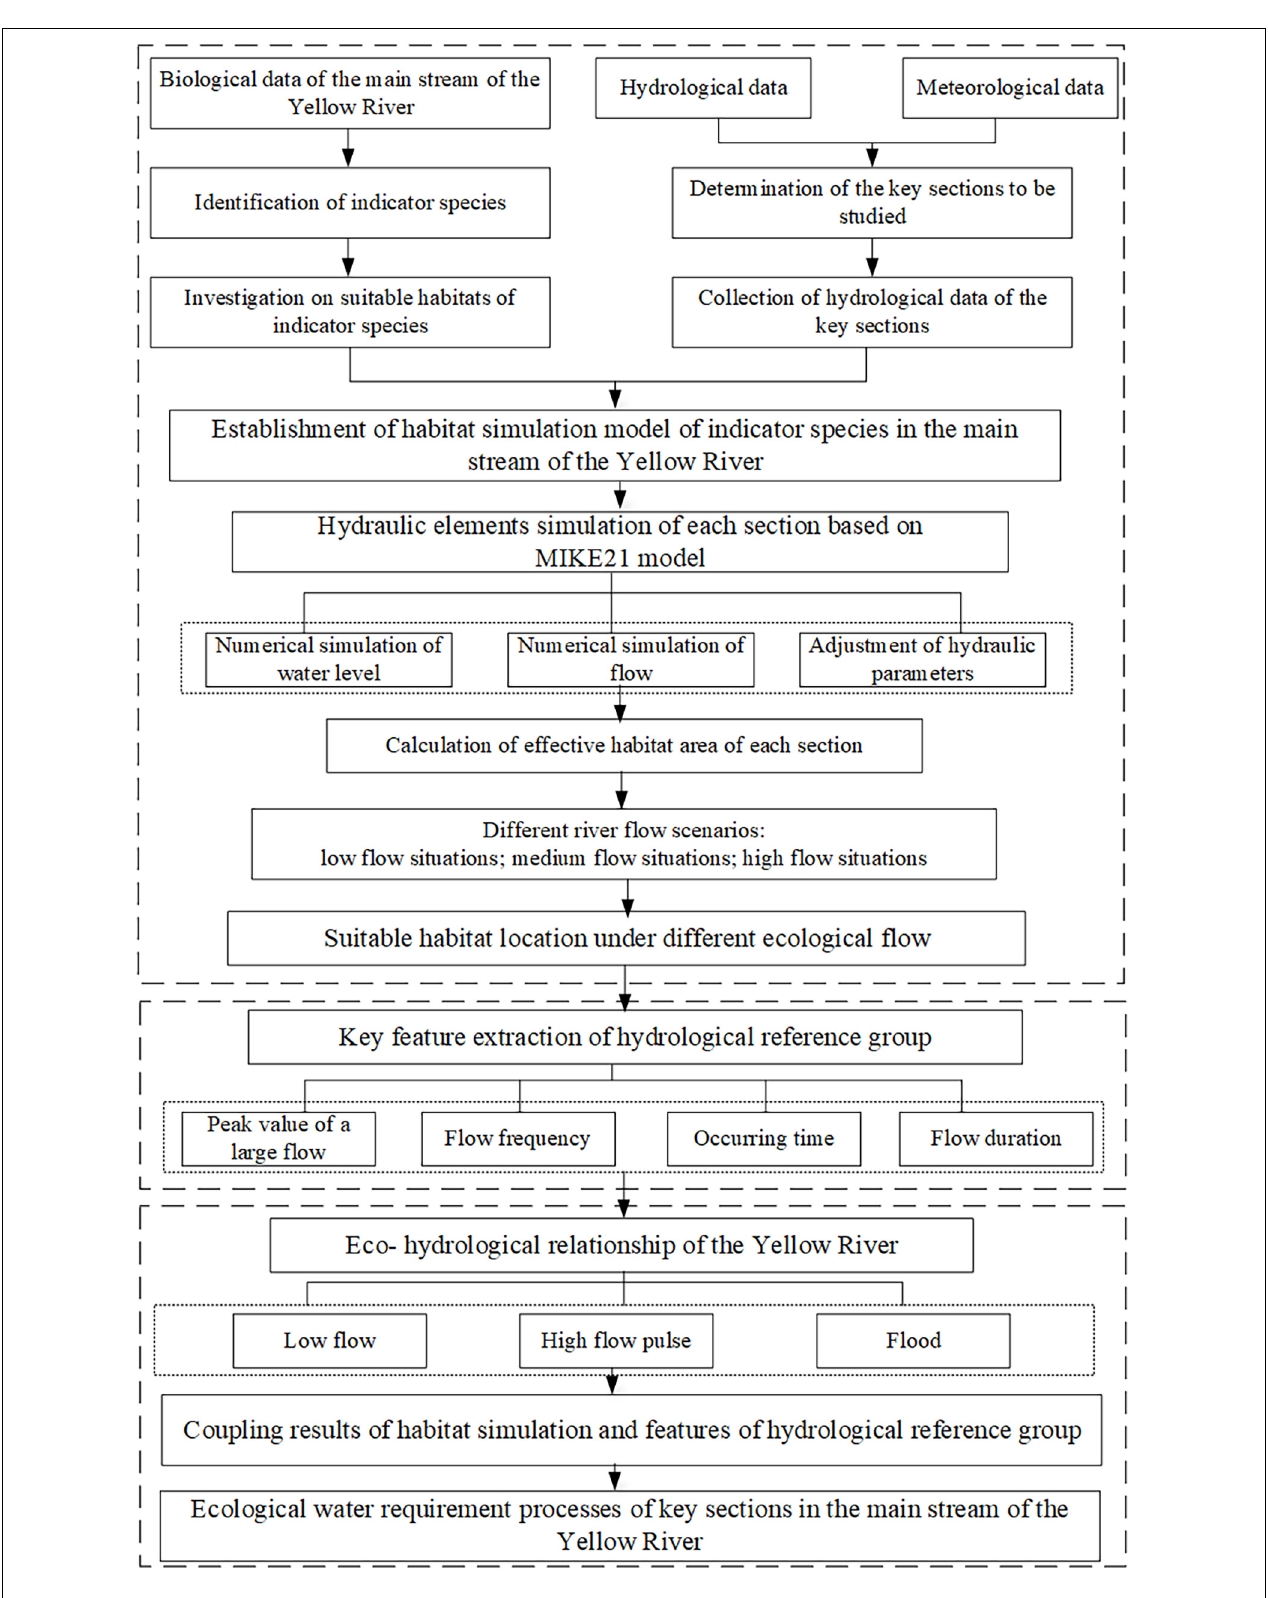
FIGURE 2 | The framework for ecological water requirement accounting from the perspective of habitat conservation.